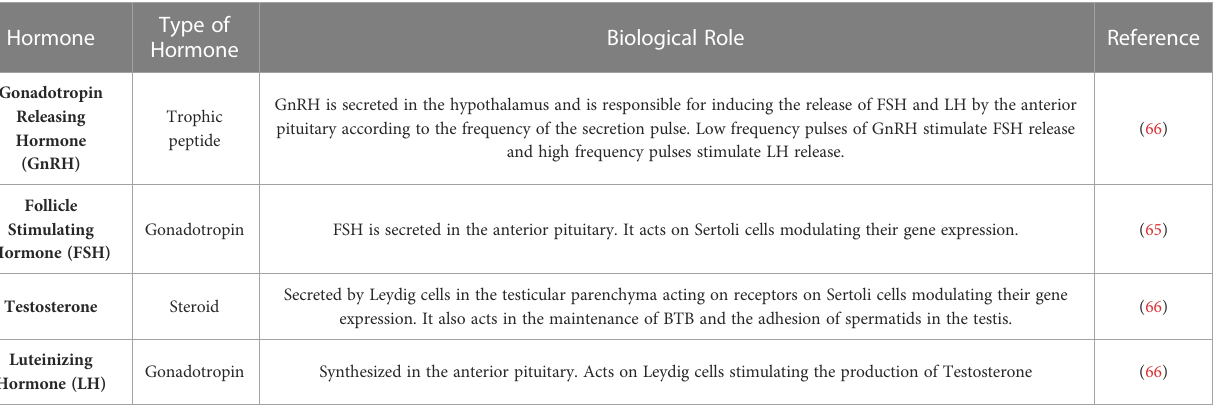
TABLE 2 Hormones involved in testicular